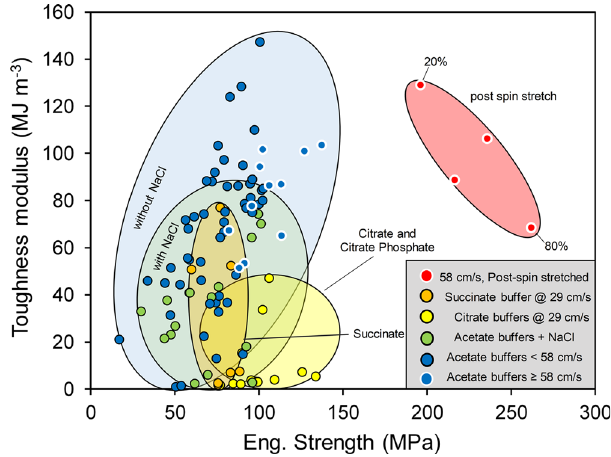
Fig. 10 An Ashby plot featuring the engineering strength and toughness modulus of all fi bers tested in this study. In total fi bers were obtained in 103 independent spinning occasions, where each point in the diagram represents the average stress and strain of n ≥ 10 fi bers spun under a speci fi c condition, except for fi bers which were post spin stretched ( n ≥